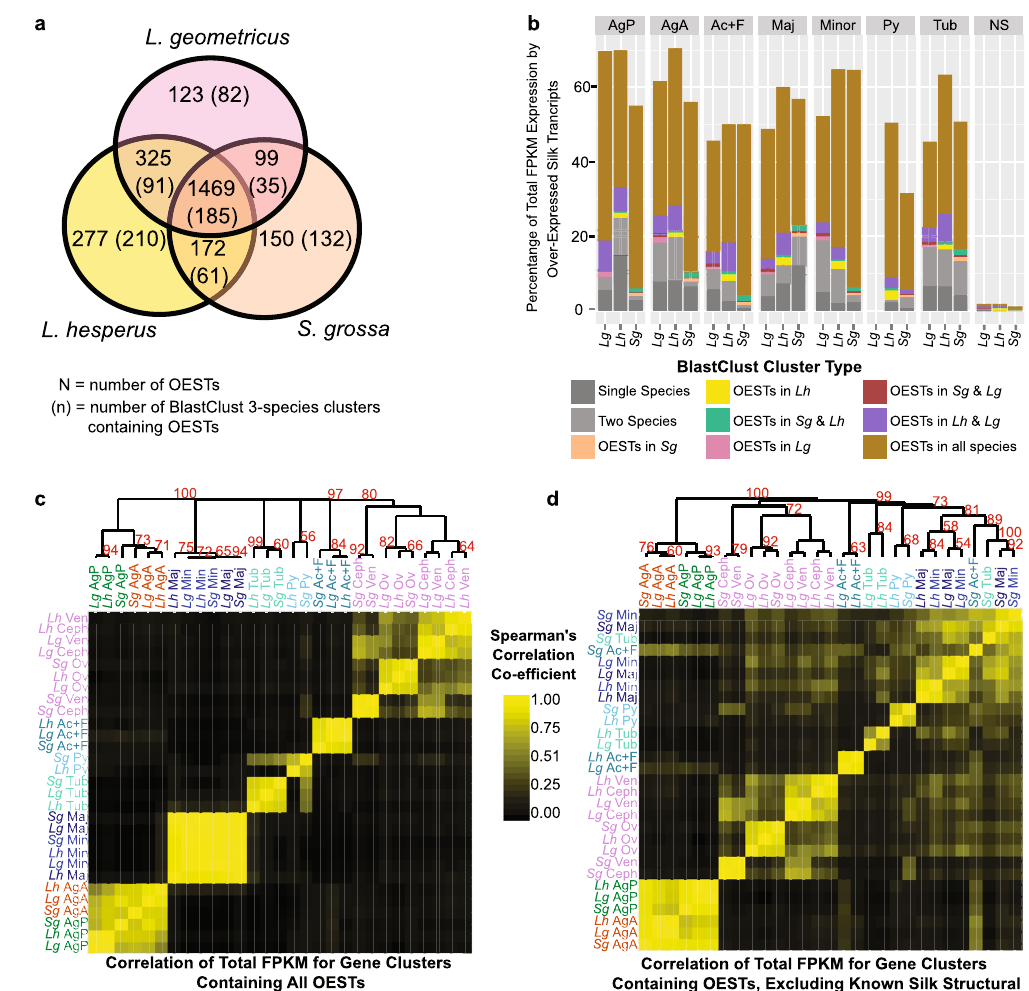
Figure 5. Conservation of expression patterns of over-expressed silk transcripts (OESTs) among cobweb weaving spider species. ( a ) OESTs with homologs in all three spider species were identified by clustering transcripts with BlastClust 30 and are referred to as BlastClust 3-species clusters. Venn Diagram indicates BlastClust 3-species clusters that contained an OEST from just one species, two species, or all three species. ( b ) Proportion of total mean FPKM in each of the silk gland and non-silk (NS) tissues attributed to OESTs in BlastClust 3-species clusters (colors), OESTs with no homologs in the other two species (dark gray), and OESTs with a homolog in only one other species (light gray). (c and d) Heat maps of pairwise Spearman’s correlation coefficients based on the summed mean FPKM of BlastClust 3-species clusters containing OESTs between each tissue type sampled from the three focal species. Correlation coefficients were used for heirarchical clustering (bootstrap proportions ≥ 50% shown). In ( c ) all OEST-containing clusters are included. In ( d ) the clusters containing known silk structural protein-encoding transcripts have been excluded. Tissue and gland abbreviations, and sample sizes, as in Figs 1 and